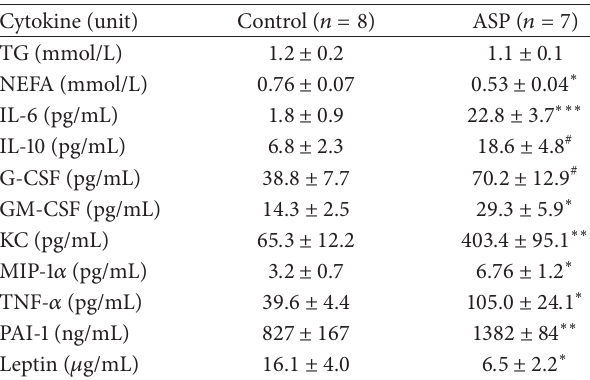
Table 2: Plasma lipids and cytokines.